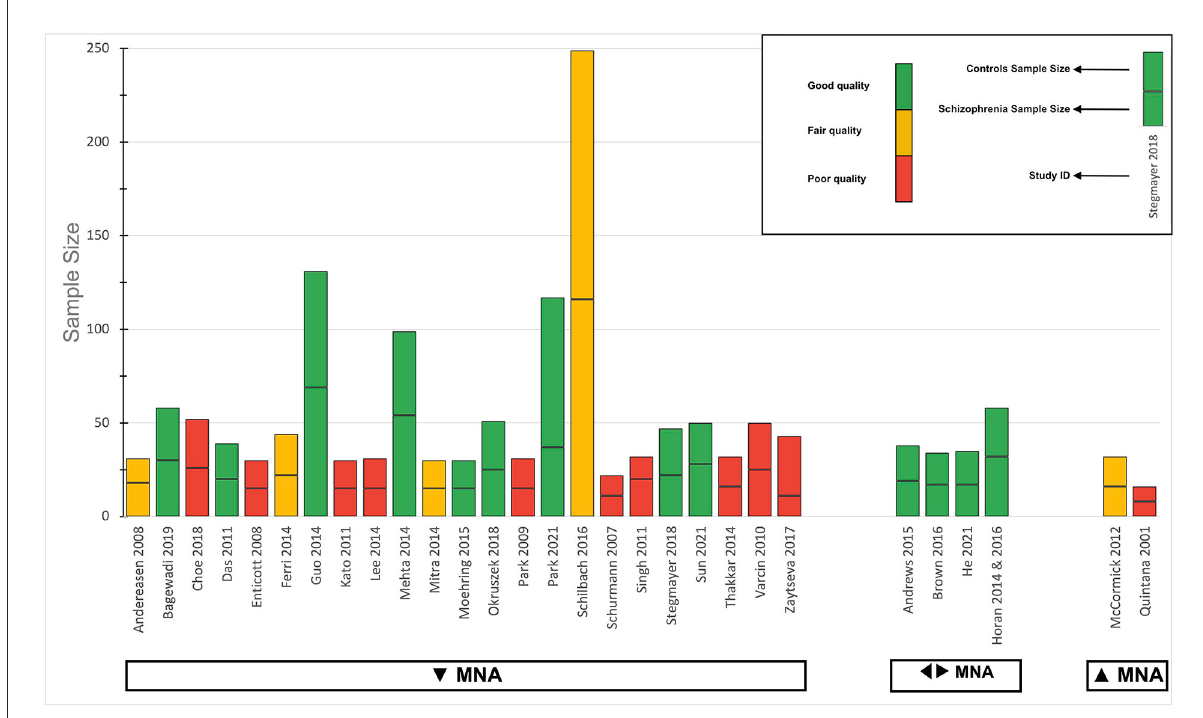
FIGURE4 Harvest plot of the overall analysis for the primary outcome. The height of each bar represents the sample size, divided by a line into two sections to represent the sample size of each group (case and control). The methodological and reporting quality of each study is presented by the color of the bar; green for good, yellow for fair, and red for poor. The direction of the effect for the studies is mentioned below the bars: H for decreased MNA, ◭◮ for intact MNA, and N for increased MNA. MNA, Mirror neuron